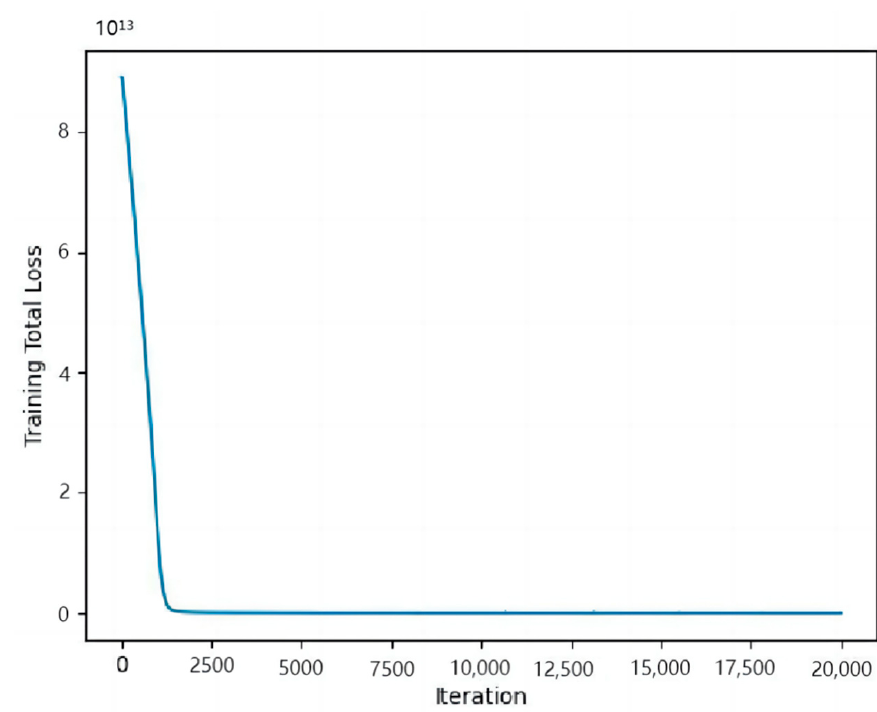
Figure 8. Overall loss function curve.